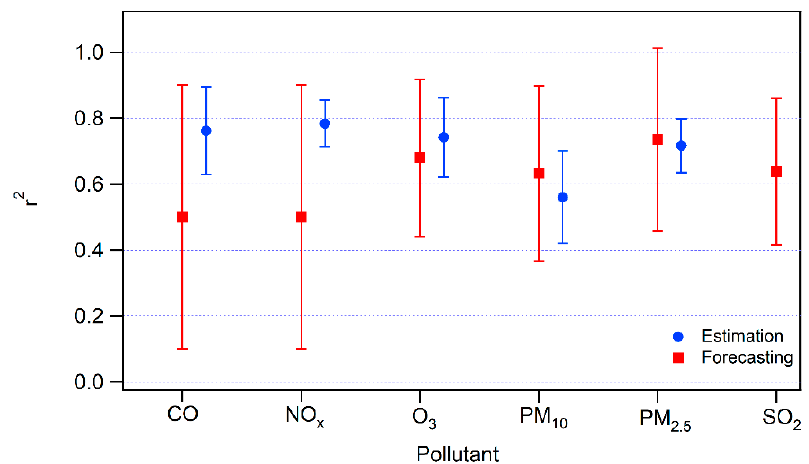
Figure 7. Model performance evaluated with the average and standard deviation of the available r 2 per pollutant of estimation and forecast studies.